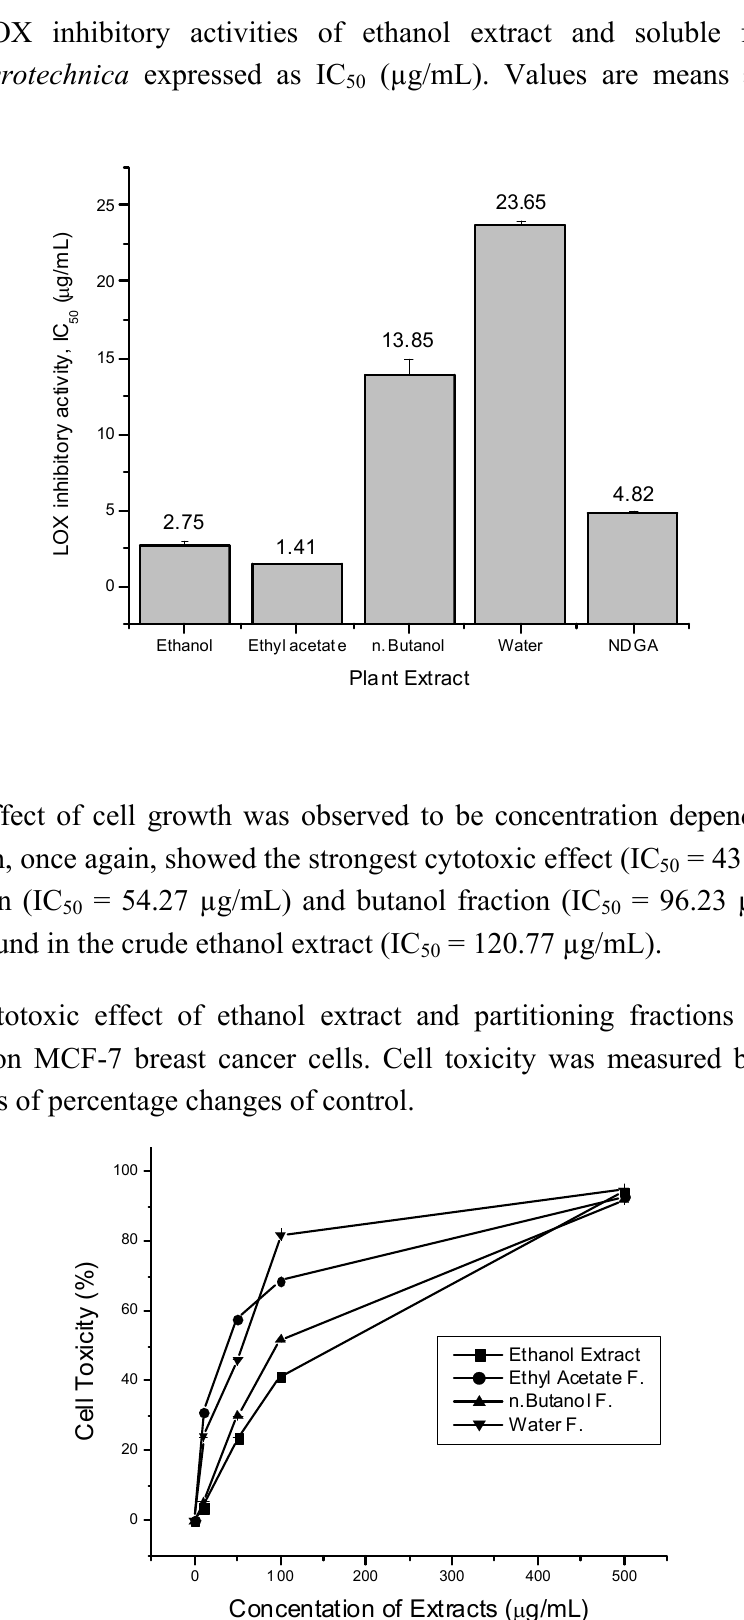
(µg/mL). Values are means ± SE of three 50